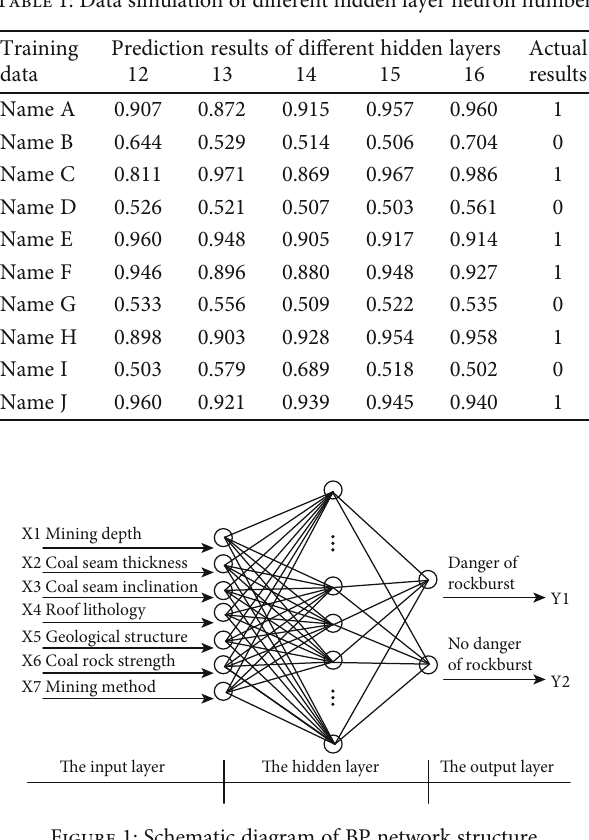
Figure 1: Schematic diagram of BP network